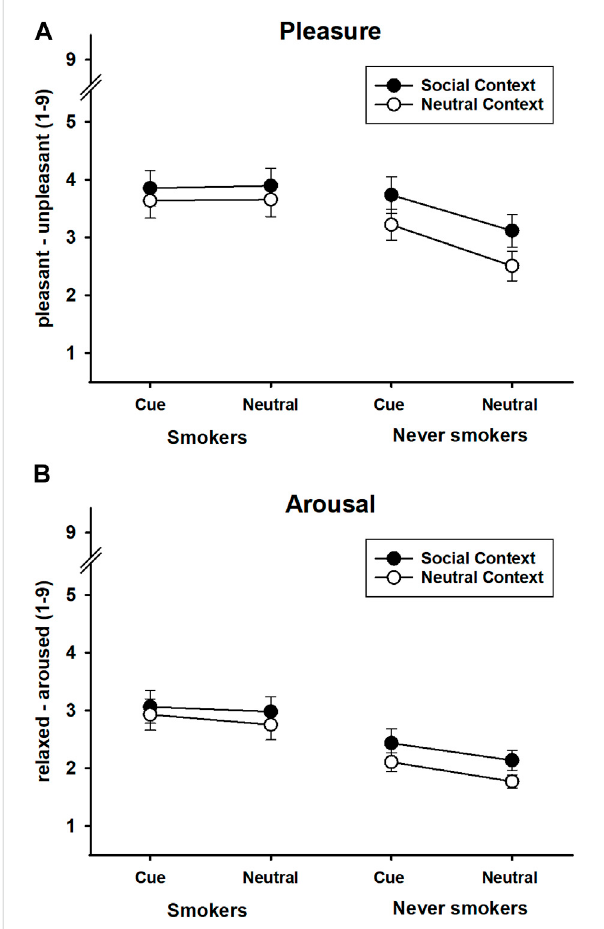
FIGURE 5 Pleasure (A) and arousal (B) in response to smoking and neutral stimuli presented in a social or neutral context in smokers and never- smokers. Error bars represent standard errors of the